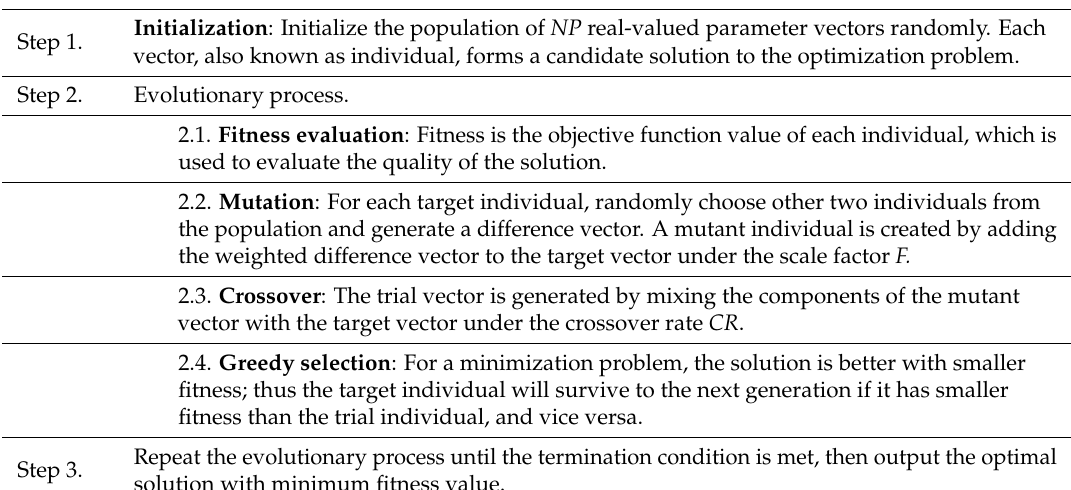
Table 2. Differential evolution